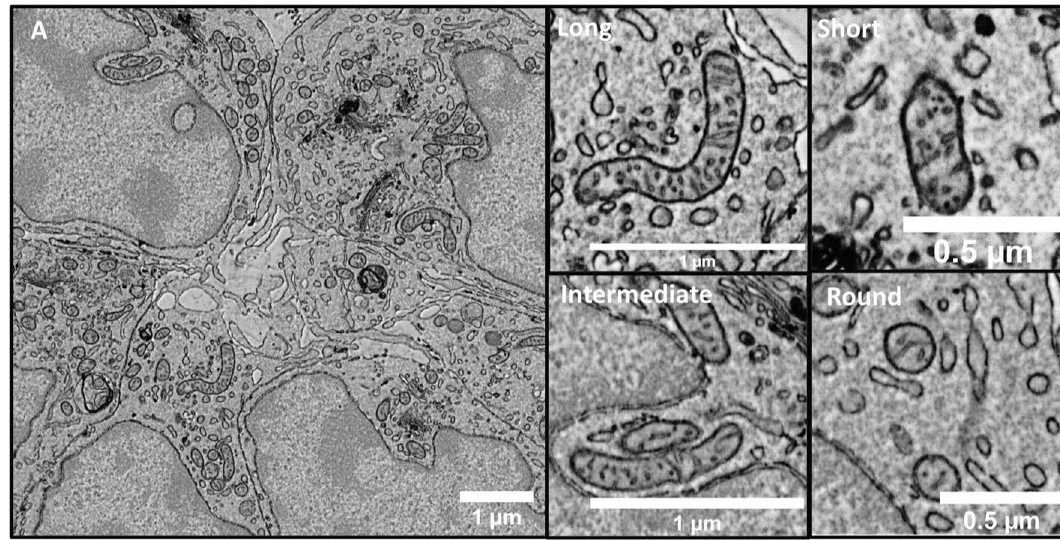
Figure 3. Scanning electron microscopy micrographs showing whole cells ( A ) and different mitochondrial morphologies in cumulus cells (long, intermediate, short, round).